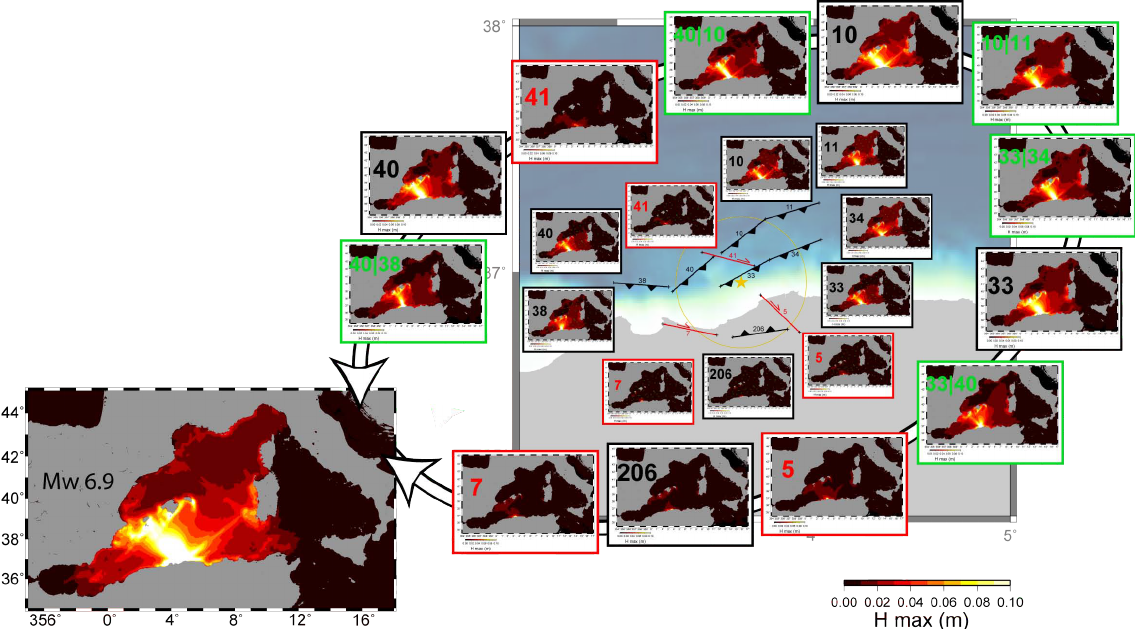
Fig. 5. Composite scenarios calculation process using the test case of the 2003 Boumerdès earthquake ( M w = 6 . 9, Algeria). (Smallest maps) maximum wave heights stored as unit source functions ( M w = 6 . 76) in the precomputed database and involved in this case; (medium maps) M w = 6 . 9 derived composite scenarios solutions from a single unit source (red contour for strike-slip source and black contour for thrust source) or the combination of the two (green contour for thrust source only); (large map, left) final composite solution for M w = 6 . 9 from all medium maps (including inaccuracy of the epicenter location).